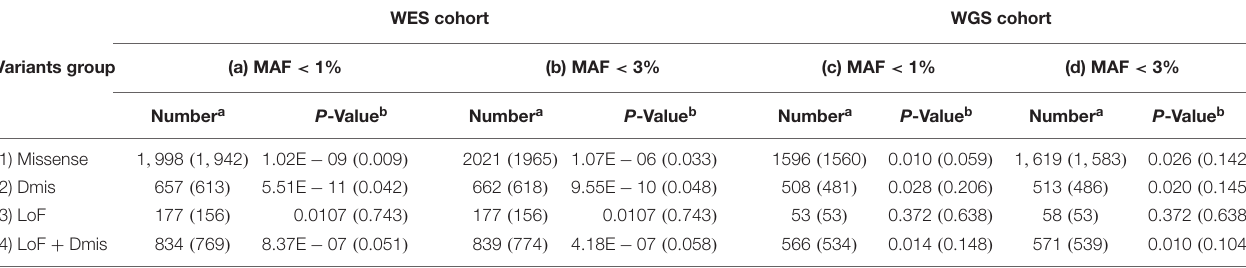
TABLE 1 | Analysis of lysosomal storage disorder (LSD) associated gene rare variant burden in Parkinson’s disease (PD). WES cohort WGS